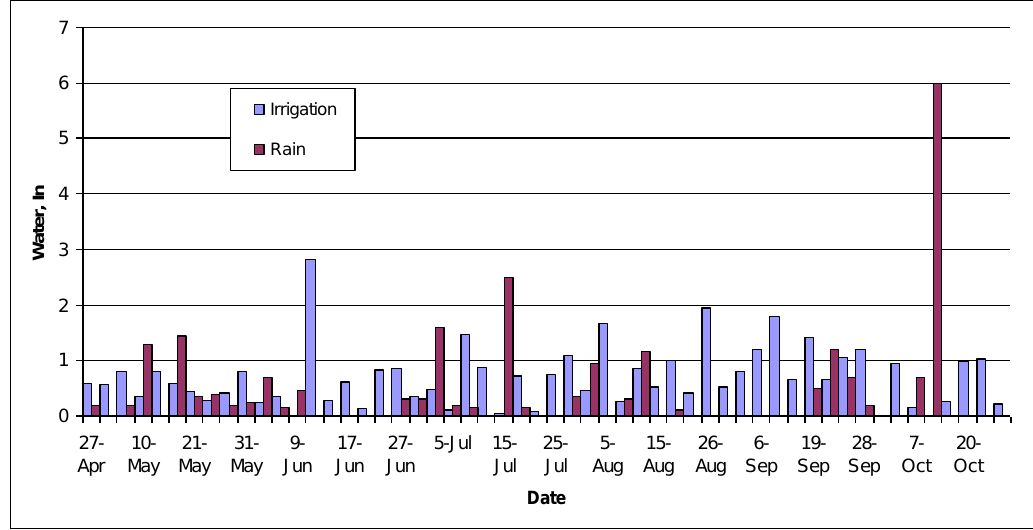
Figure 1. Rainfall and irrigation applied to the experimental site from April to October, 2005. The cumulative amounts of water were 584 mm (23 inches) from rainfall and 1370 mm (54 inches) from